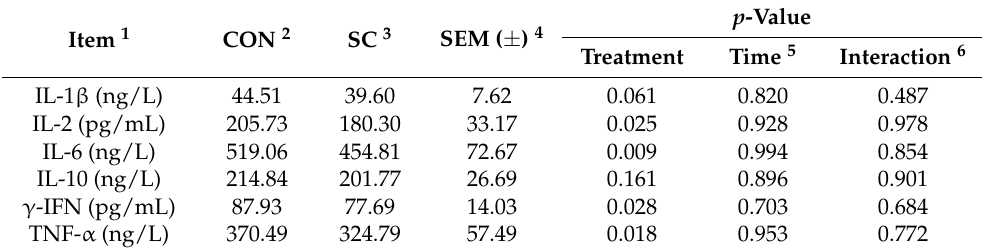
Table 5. Effects of SC on inflammatory cytokine of high-yield lactating